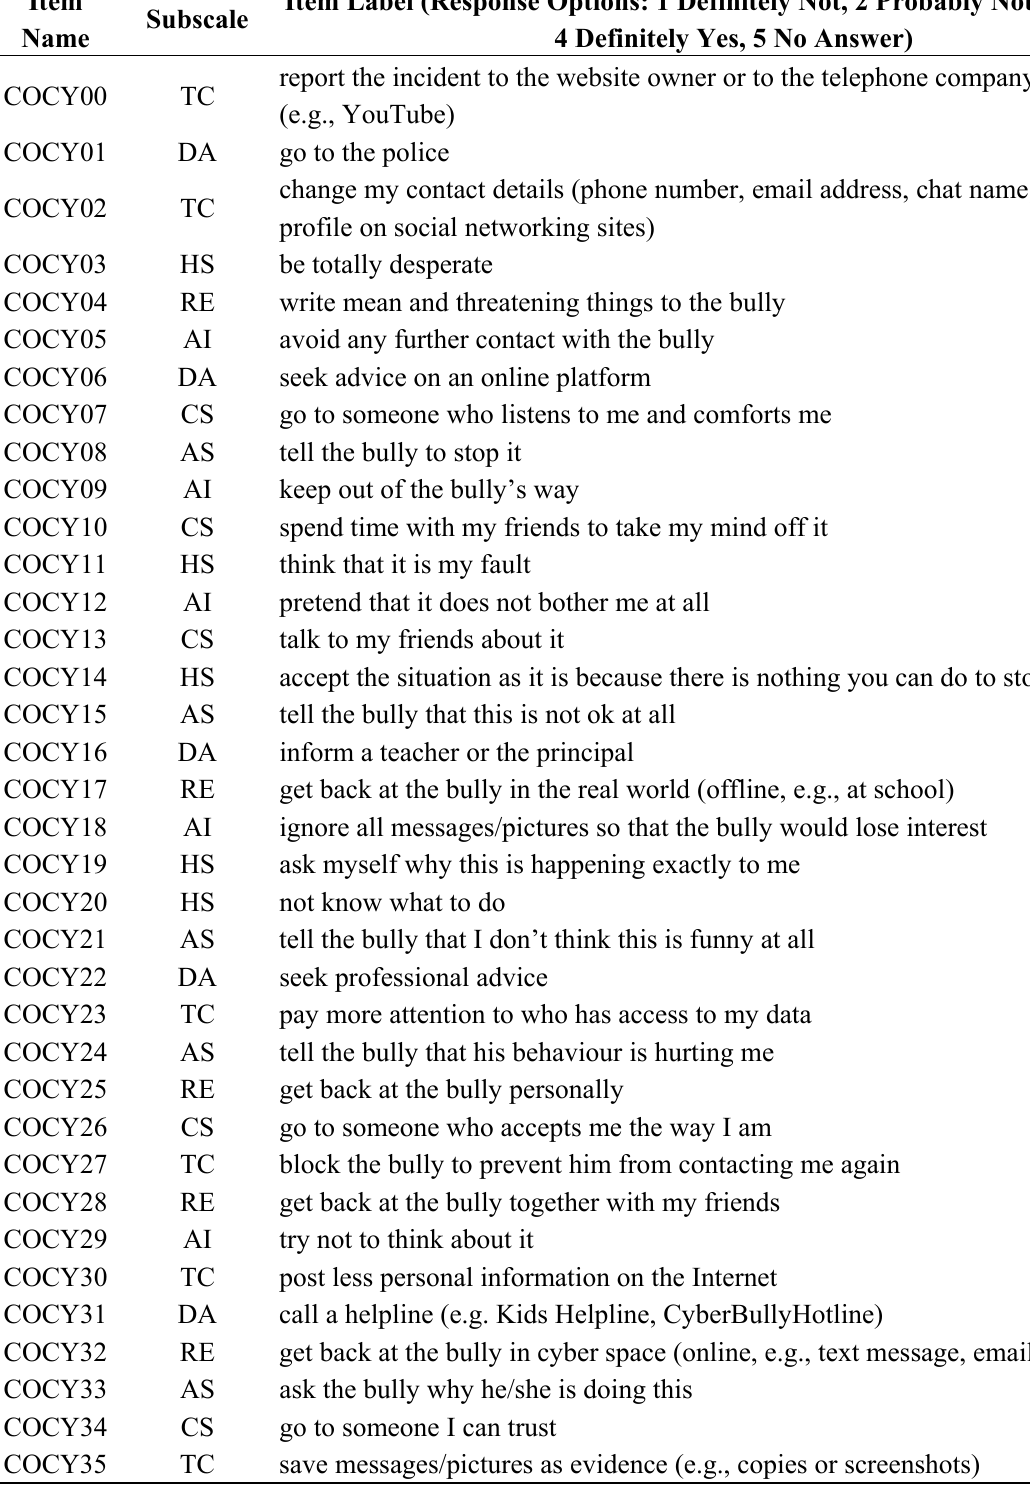
Table A1. Current English version of the Coping with Cyberbullying Questionnaire (CWCBQ).